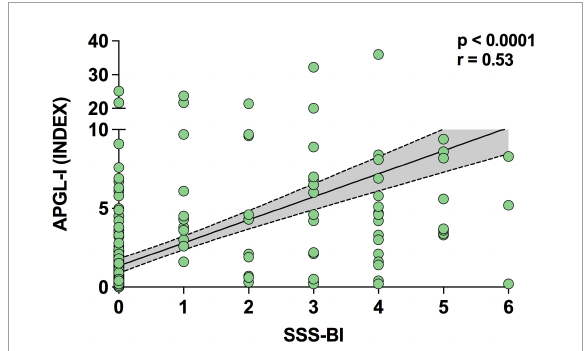
FIGURE3 The APGL-I serology index shows a moderate positive correlation with the SSS bacillary load. Spearman’s correlation coefficient was used to compare the bacterial index in the SSS (BI-SSS) with the APGL-I index. SSS, slit-skin smear; APGL-I, IgM anti-phenolic glycolipid-I.